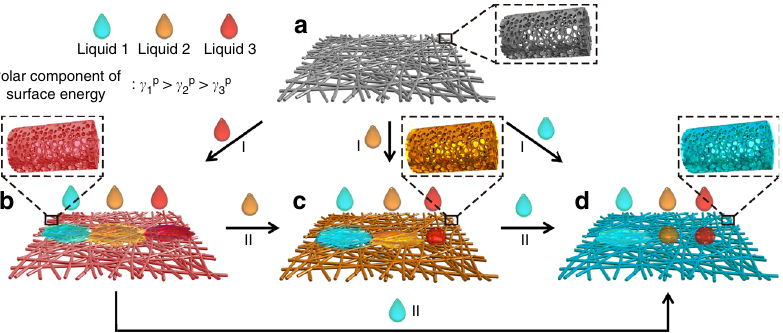
Fig. 3 Schematic of the infused-liquid-switchable wetting behavior of STPNMs based on polarity. a The STPNMs are superamphiphilic in air for any > γ p > γ p immiscible liquids with different PSEs ( γ p ) and can be infused to form liquid-LII, respectively (process I). The liquid-LII shows switchable wetting 1 2 3 behavior upon the infusion by different liquids. b The liquid 3-LII with the lowest PSE is lyophilic for all of the three liquids. c The liquid 2-LII with medium PSE is lyophobic for liquid 3 but lyophilic for liquid 1. d The liquid 1-LII with the highest PSE is lyophobic for both liquids 2 and 3. Moreover, the